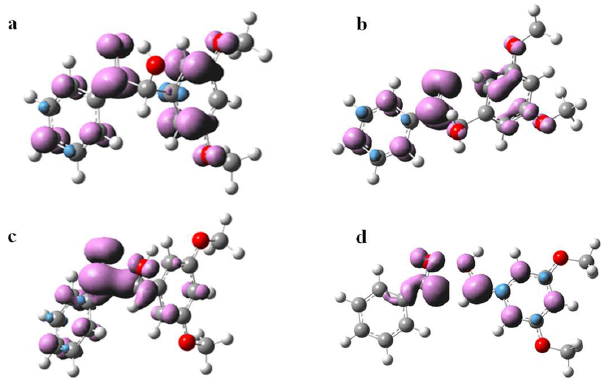
Figure 9. Isosurfaces of the spin density of ( a ) DMB (T ππ *), ( b ) DMB (T n π *), ( c ) transition state of α -cleavage and ( d ) radicals generated by α -cleavage at the optimized geometries (triplet state). The calculations were carried out at the B3LYP / 6-311 + g(d,p) (MeCN) level of theory (Isovalue =